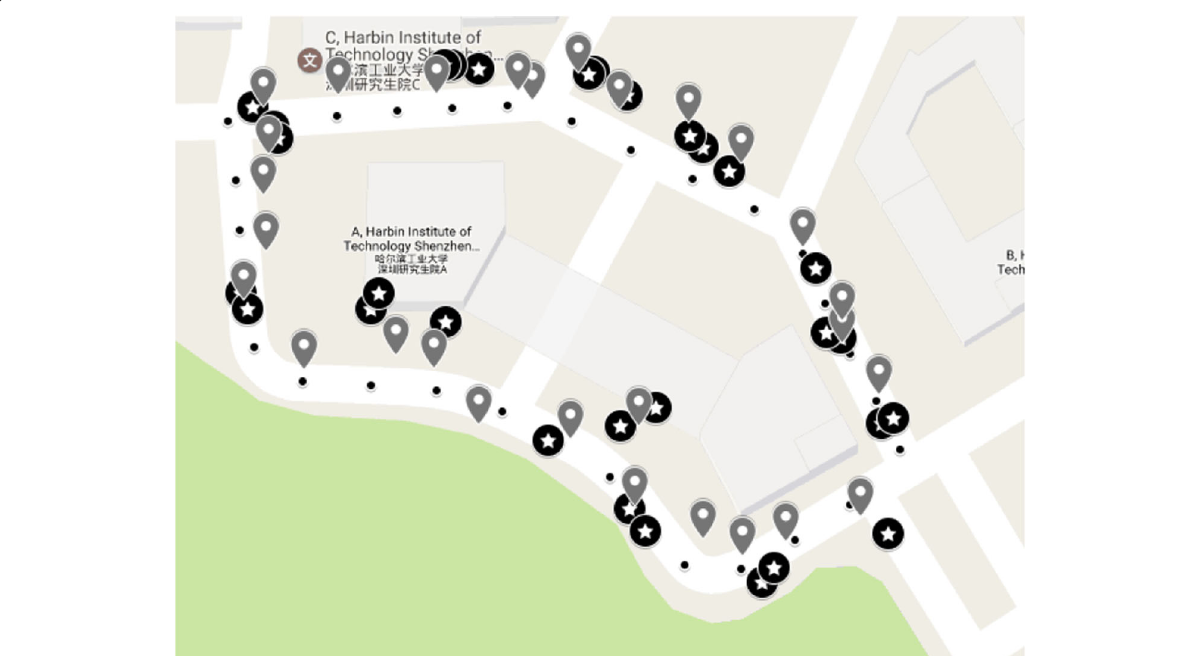
Fig. 6 Distribution of pre-calibrated points, GPS positioning results and our hybrid results, represented by black dots, gray icons, and black star icons,